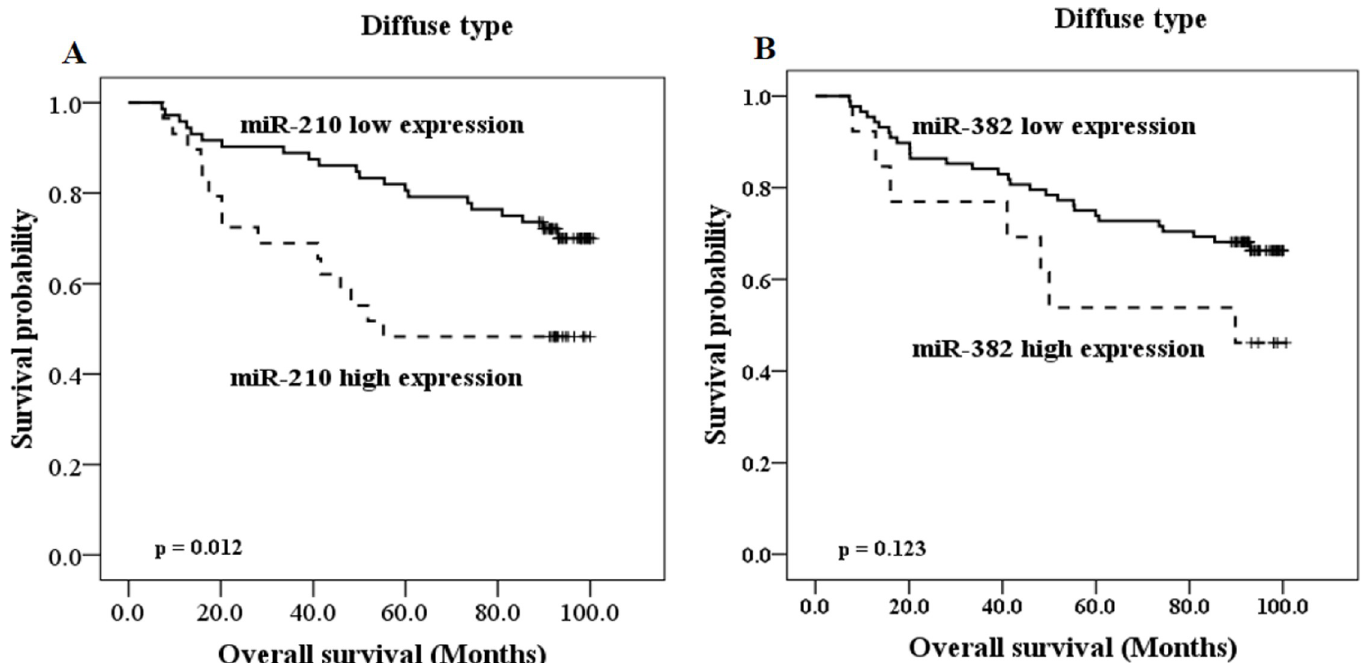
Fig 2. Prognostic values of miR-210 and miR-382 expression in subgroup analysis according to Lauren classification diffuse type GC. Estimated Kaplan-Meyer curves of overall survival for (A) miR-210 and (B) miR-382 in 101 patients with diffuse type GC.